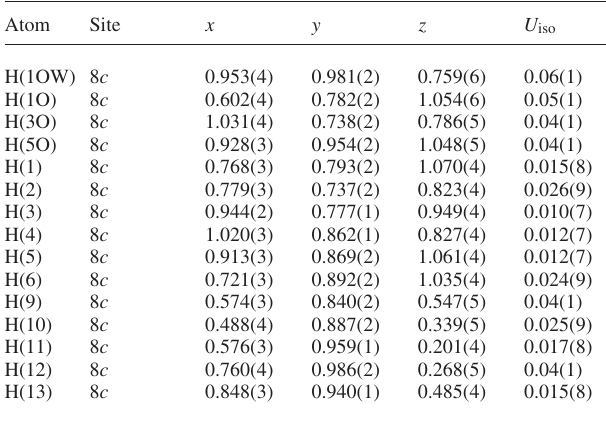
Table 2. Atomic coordinates and displacement parameters (in Å 2 )